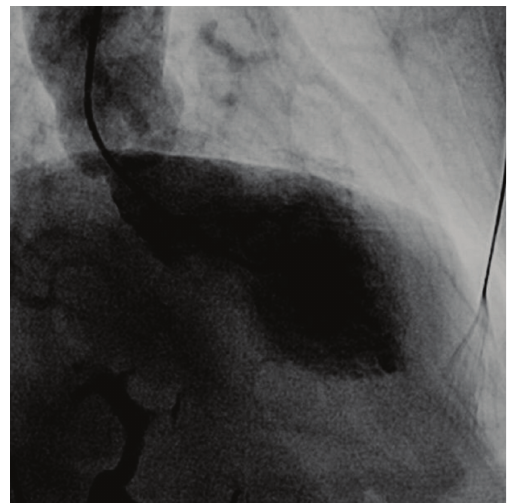
Figure 3: Anteroapical ballooning of left ventricle during systole as seen on left